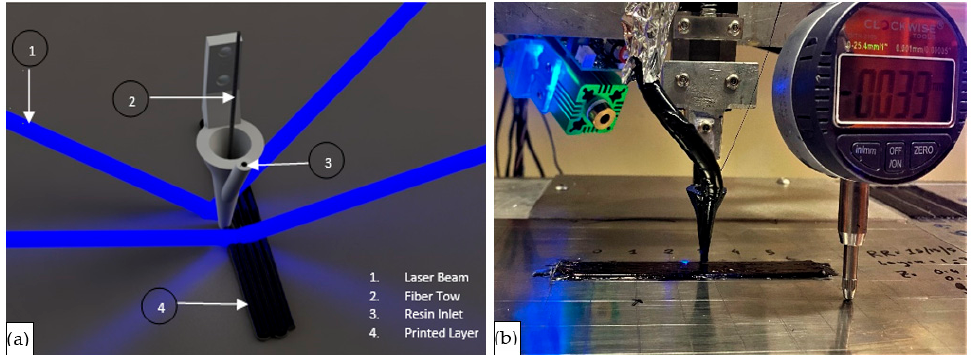
Figure 2. ( a ) Schematic of composite 3D printing process. ( b ) Actual printing process. Composite rectangular bars were printed for mechanical property